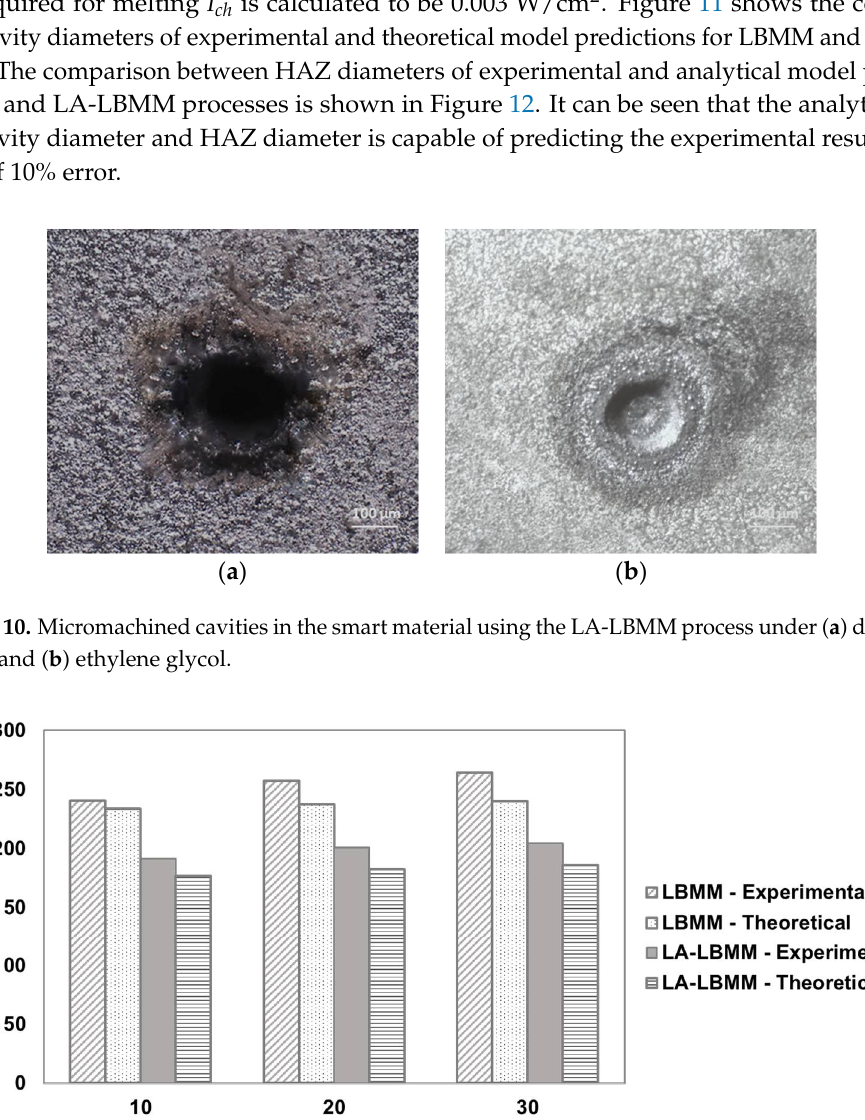
Figure 12. Comparison between HAZ diameters of experimental and analytical model predictions for the LBMM and LA-LBMM processes.